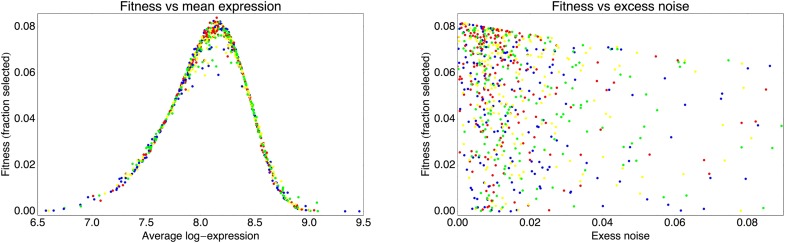
Fitness of the observed clones, as given by Equation 76, as a function of their mean expression μ (left panel) and their excess noise η (right panel).As in Appendix 2—figure 3, the blue dots correspond to clones from the third and fifth round of the evolutionary run, the red dots result from another round of stringent selection (top 1%), the yellow dots from another round of standard selection (top 5%), and the green dots from a round of weaker selection (top 25%).